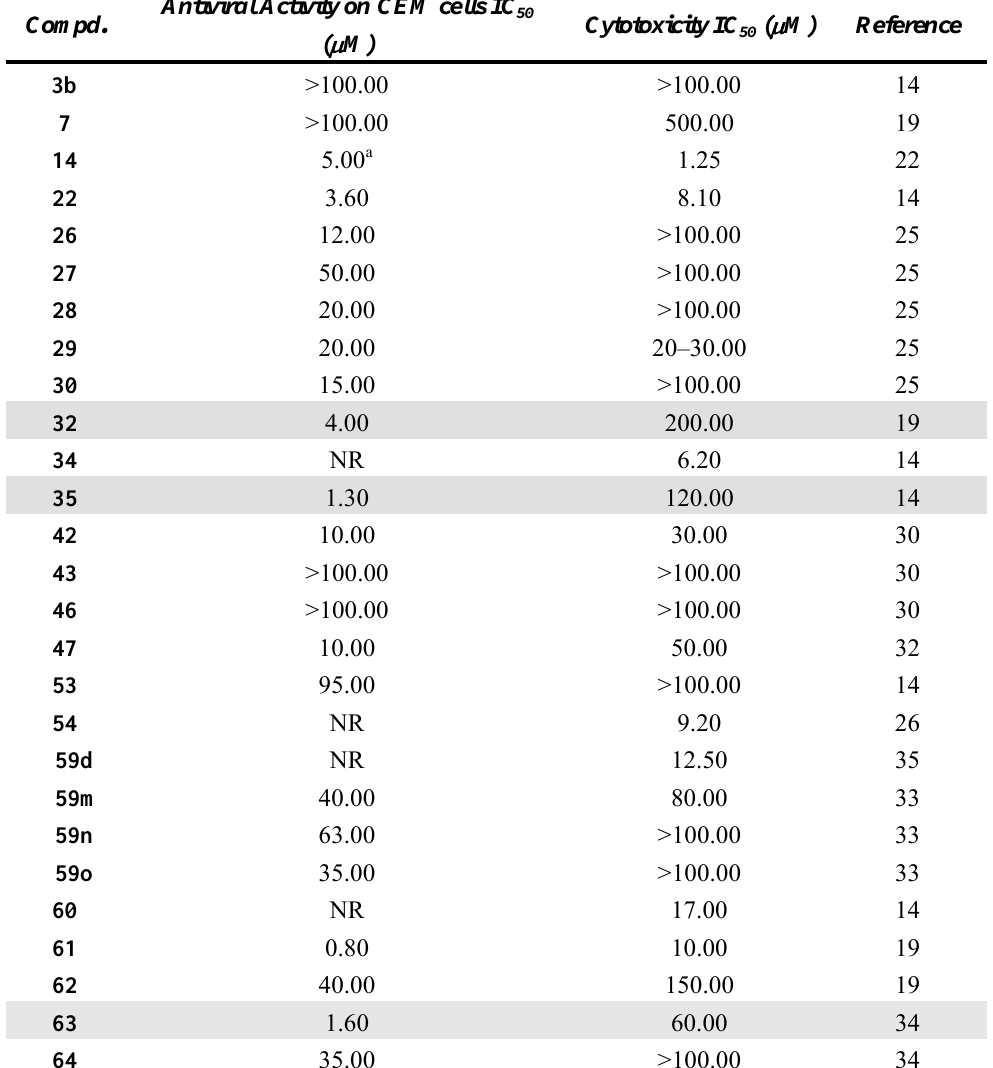
Table 10. Antiviral activity and cytotoxicity of the (3’,4’-dihydroxyphenyl)styrylquinoline